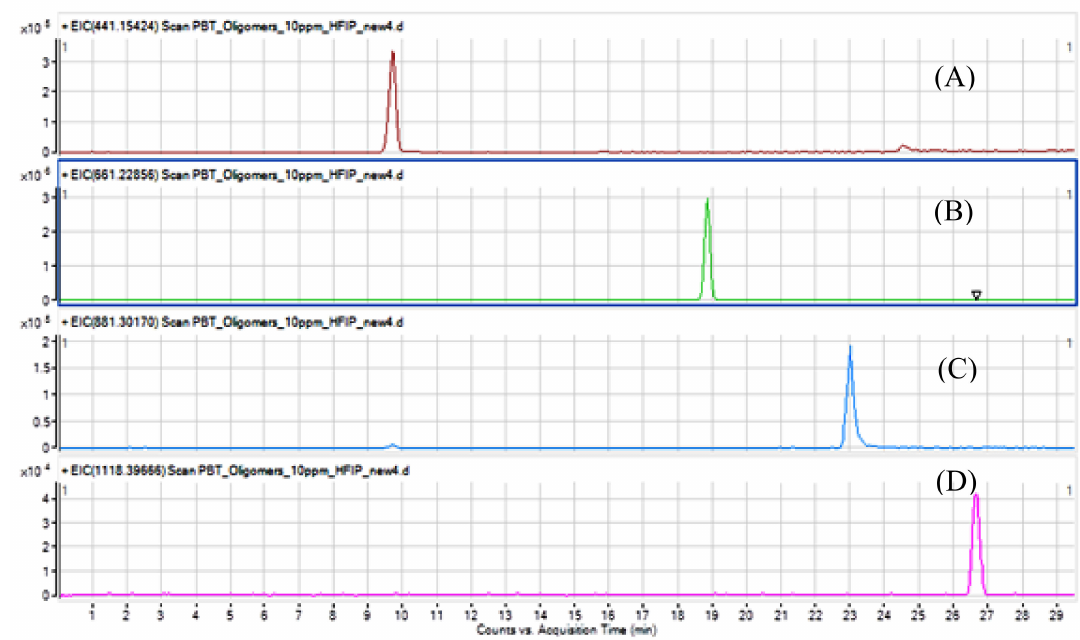
Figure 3. UHPLC-qTOF-MS chromatograms of 2 µ g mL − 1 cyclic PBT oligomers: ( A ) dimer; ( B ) trimer; ( C ) tetramer and ( D )